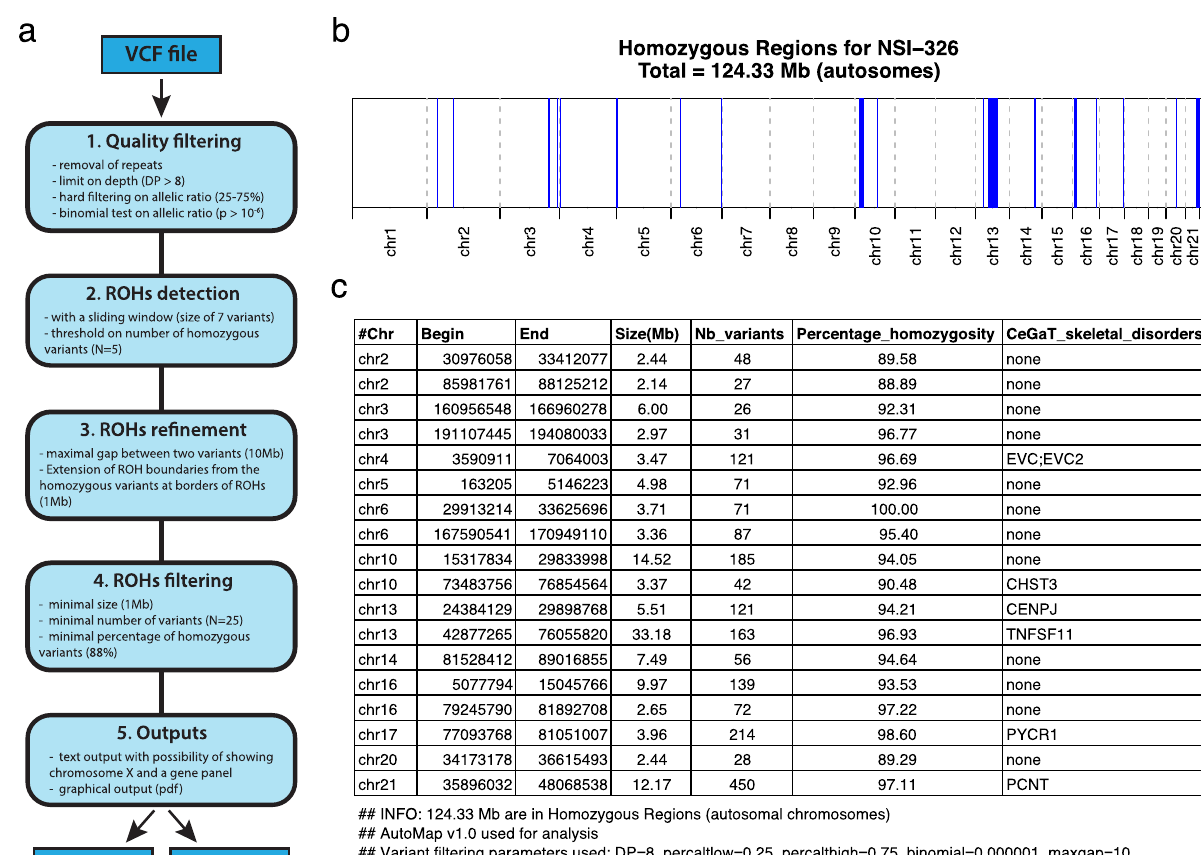
Fig. 1 AutoMap work fl ow and example of output. a Work fl ow followed by AutoMap with default settings, b , c example of graphical and text output for patient NSI-326, with the following parameters: DP = 8, percaltlow = 0.25, percalthigh = 0.75, binomial = 0.000001, maxgap = 10, window = 7, windowthres = 5, minsize = 2, minvar = 25, minperc = 88, chrX = No, and extend = 1. Blue regions represent detected